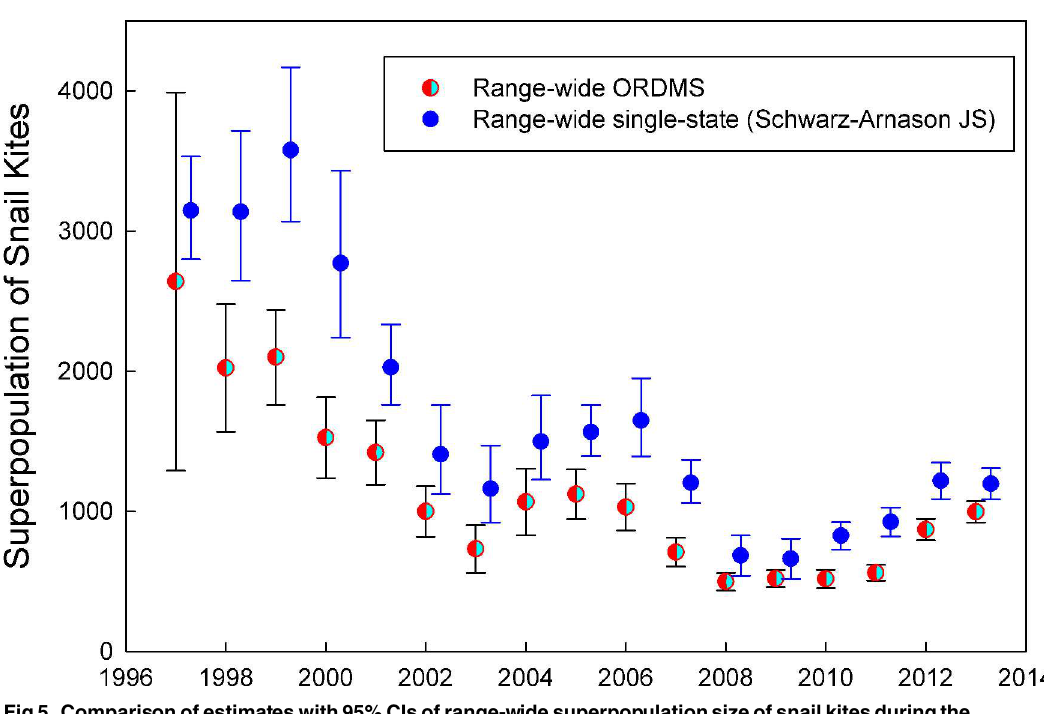
Fig 5. Comparison of estimates with95% CIs of range-wide superpopulationsize of snailkitesduringthe breedingseasonin Floridausingsingle-stateand open robust designmultistatemodels.